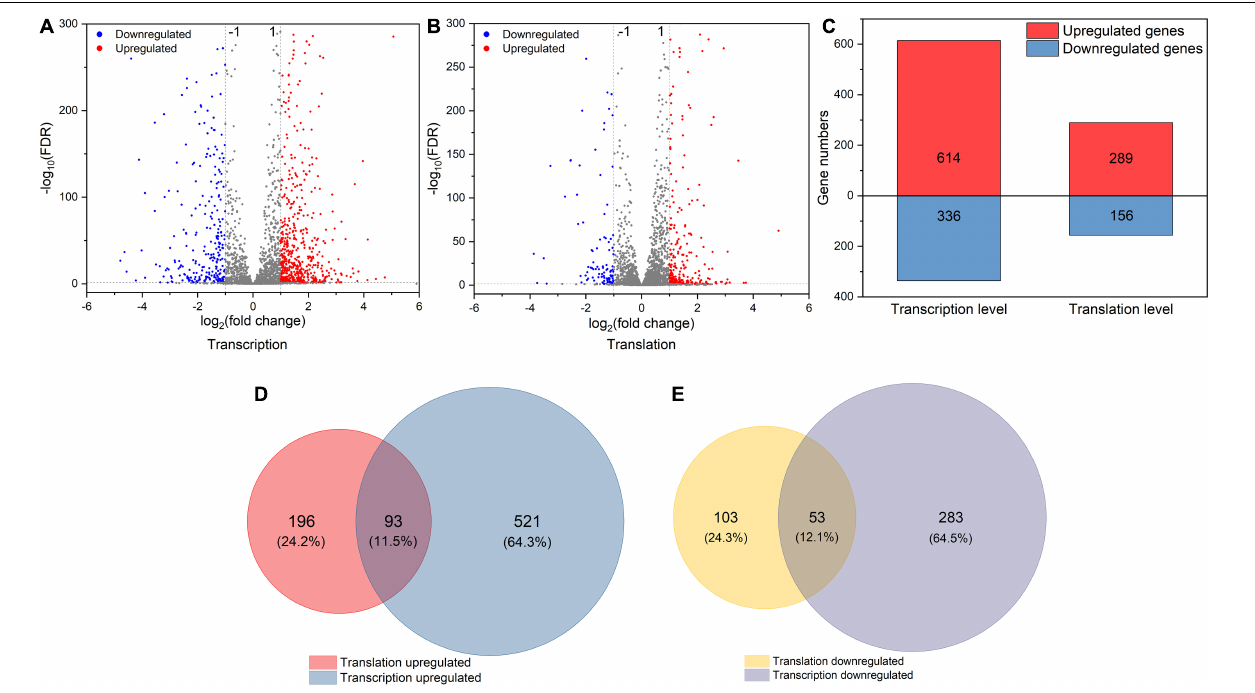
FIGURE 2 | (A,B) The volcano plot of DEGs ( | log 2 FC | > 1 and FDR < 0.05) at transcription and translation levels under osmotic stress. (C) The number of DEGs at transcription and translation levels under osmotic stress. (D,E) The relationship between osmotic responsive genes at transcription and translation levels. Genes analyzed in Figure 1 (D,E) were derived from Figure 1 (A,B) .